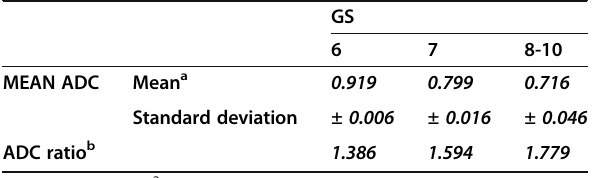
Table 5 Demonstrating the mean ADC value and the standard deviation of different grades of the tumor in the